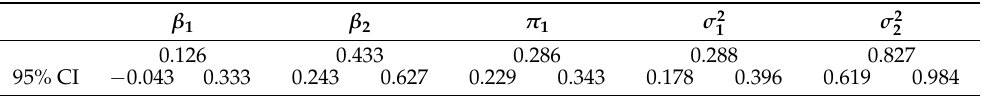
Table 7. Parameter estimates of the fitted model (38) and the corresponding 95% bootstrap confi- dence